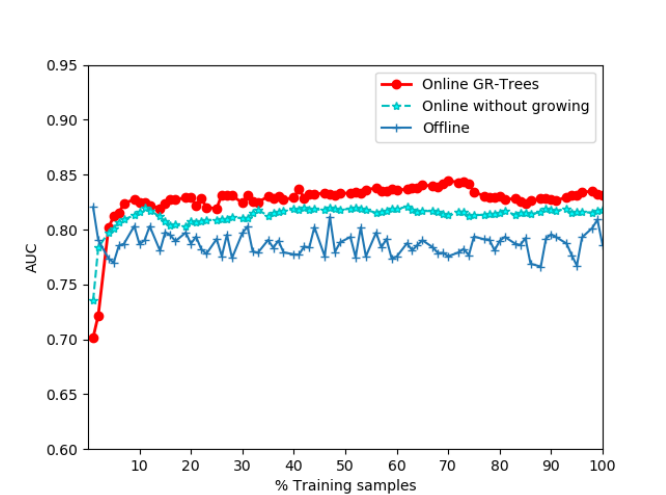
Figure 3. AUC (Area Under the receiver operating characteristic Curve) scores with respect to the ratio of training samples for online Growing Random Trees (GR-Trees; red solid), the online model without growing (cyan dashed), and the offline model (blue solid) with an increasing number of training samples from the SWaT